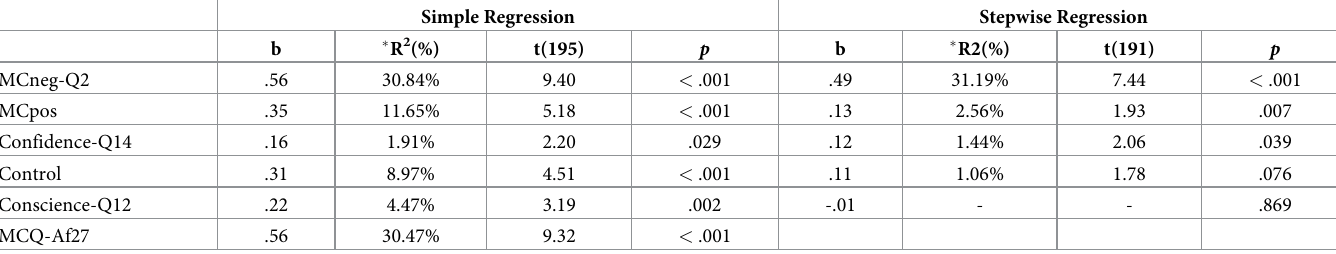
Table 4. Simple and stepwise linear regressions of the 5 factors of the MCQ-Af27 on anxiety scores, N = 197. Simple